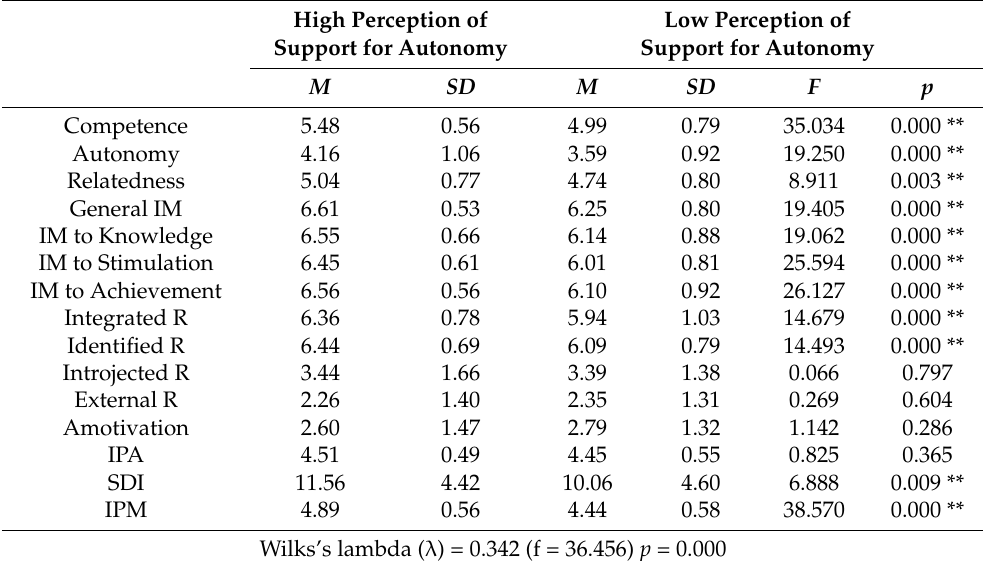
Figure 1. Perceived autonomy profiles for the different variables. Table 3. Multivariate analysis of basic psychological needs, motivation, intention to be physically active, and controlling